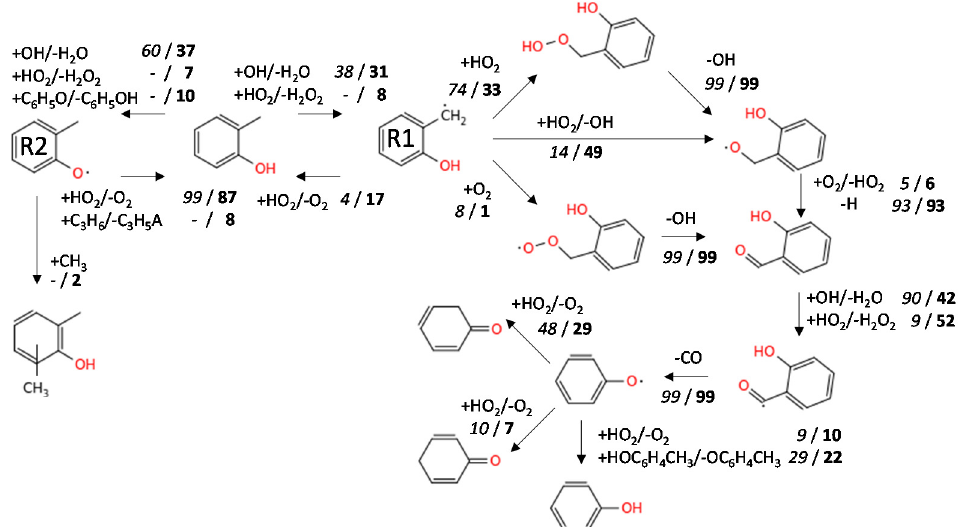
Figure 6. Rate of production analysis for the submechanism of ortho -cresol in the case of a stoichiometric 80/20 iso -octane/ ortho -cresol blend at T C = 686 K. P C = 20 bar.Italic numbers correspond to 5% ortho -cresol conversion (i.e., first-stage ignition), bold numbers to 75% ortho -cresol conversion (i.e., final ignition).